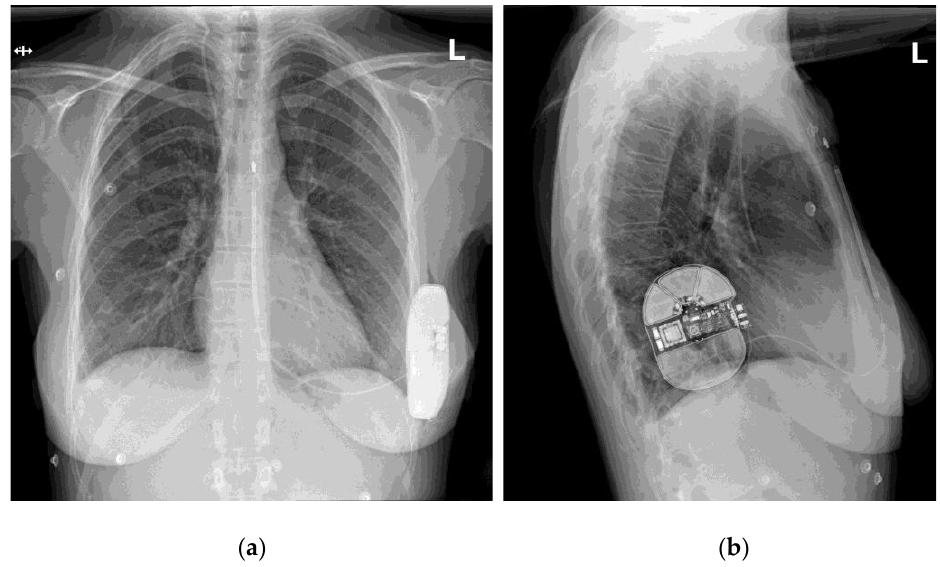
Figure 1. An exemplary set of X-ray pictures of the S-ICD system implanted in one of our patients, two projections: ( a ) postero-anterior view; ( b ) lateral view. Table 1. Demographic and clinical data of patients included in the study